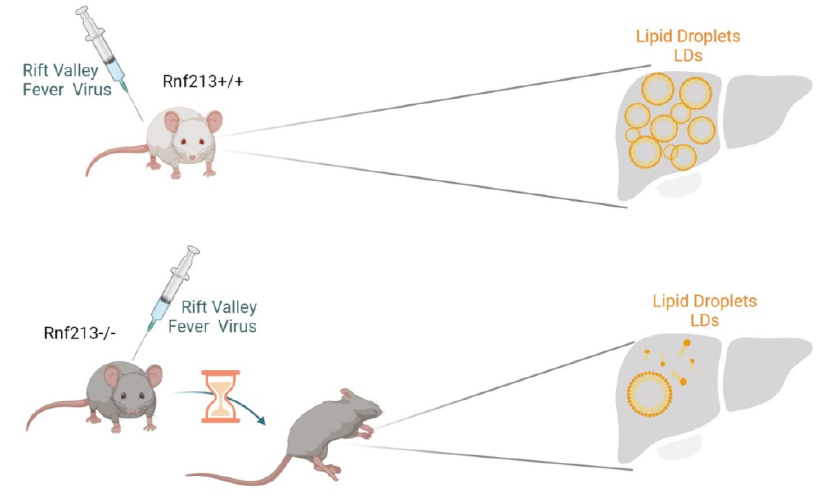
Figure 3. RNF213 protects against RVFV (Rift Valley Fever Virus) infection by increasing the level of LDs (lipid droplets).